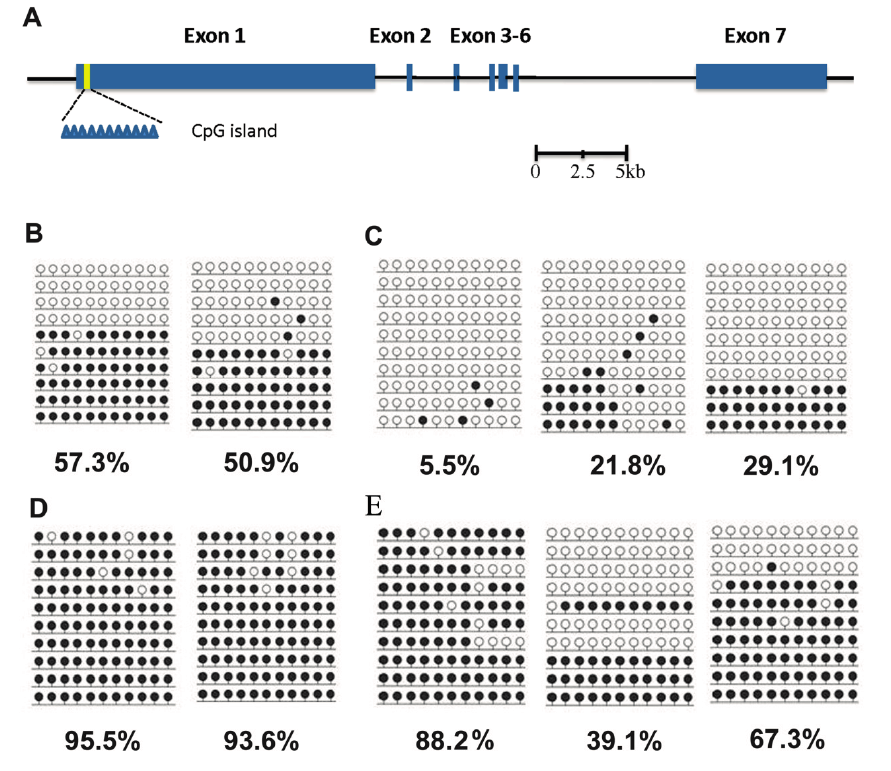
Figure 3. Methylation status of Xist DMR. ( A ) Gene structure and precise location of the CpGs in the porcine Xist gene. Blue rectangles represent the seven exons of porcine Xist, the yellow region represents the location of CpG island. The eleven blue triangles represent the number of CpG within the DMR; ( B ) Control female fetuses; ( C ) Aborted female fetuses; ( D ) Control male fetuses and ( E ) Male aborted fetuses. A filled black circle